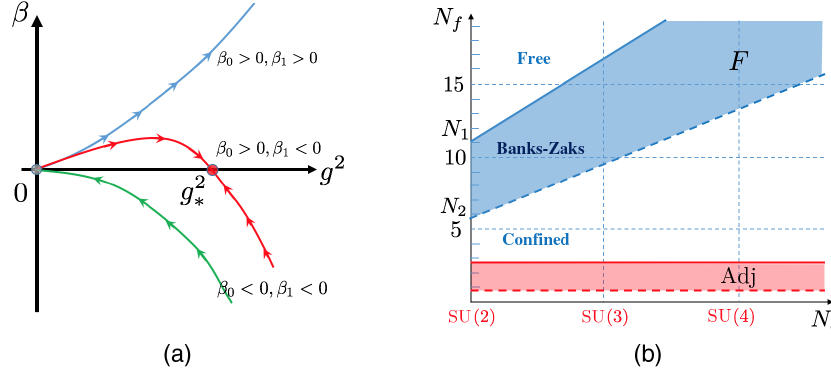
FIG. 2. (a) The renormalization group flow of the gauge coupling in three different regimes: (1) IR free (green curve), (2) Banks-Zaks fixed point (red curve), conformal, and (3) IR confined (blue curve). (b) The conformal window for SU ð N flavors of fundamental or adjoint fermion fields. The upper edge of the conformal window is sharply determined by the condition β 0 . The lower edge of the conformal window can only be determined through numerical simulations and higher-loop 0 ð N c ; N f ; R Þ ¼ calculations. Therefore, one should not take the numbers on the dotted line literally.